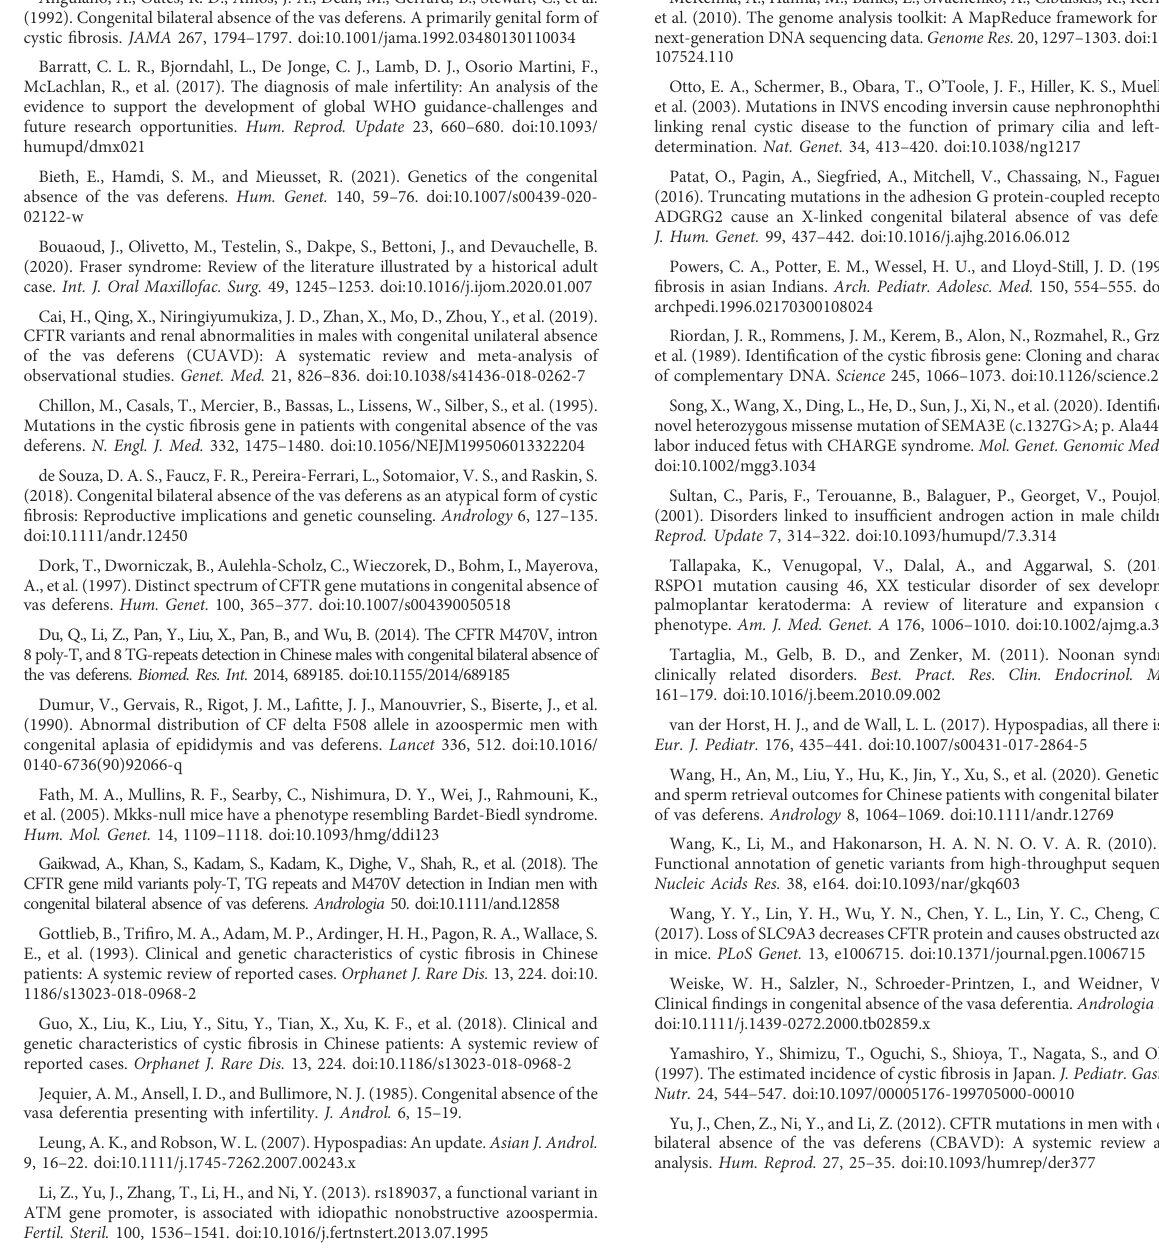
SUPPLEMENTARY TABLE S1 CFTR mutations identi fi ed in CAVD